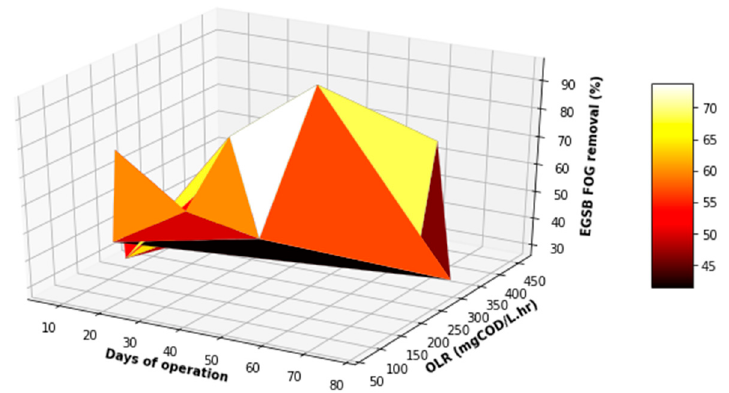
Figure 11. Variation in FOG removal with differentiated OLR during the EGSB operational time.